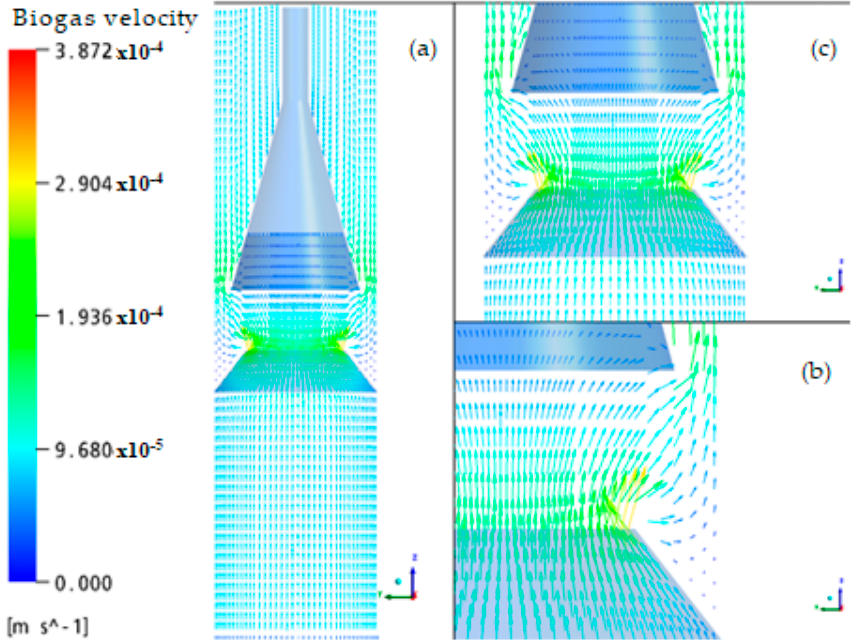
Figure 6. Water velocity vector in the reactor with deflector inclination upwards: ( a ) overview, ( b ) detail of the region between the gas deflector and the three-phase separating element, and ( c ) detail of the region corresponding to the settling zone.